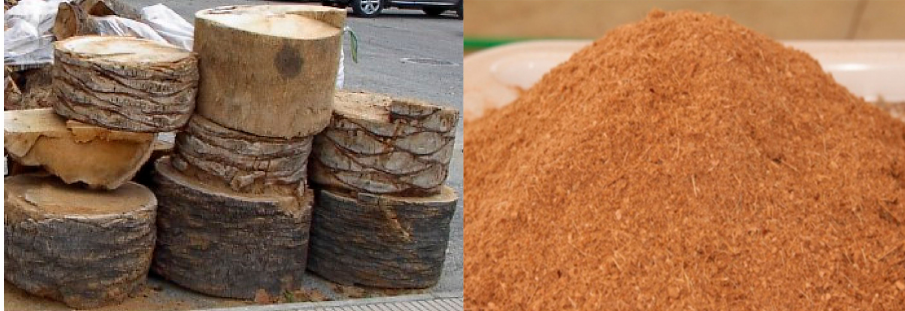
Figure 1. Palm trunks infested with red palm weevil and palm